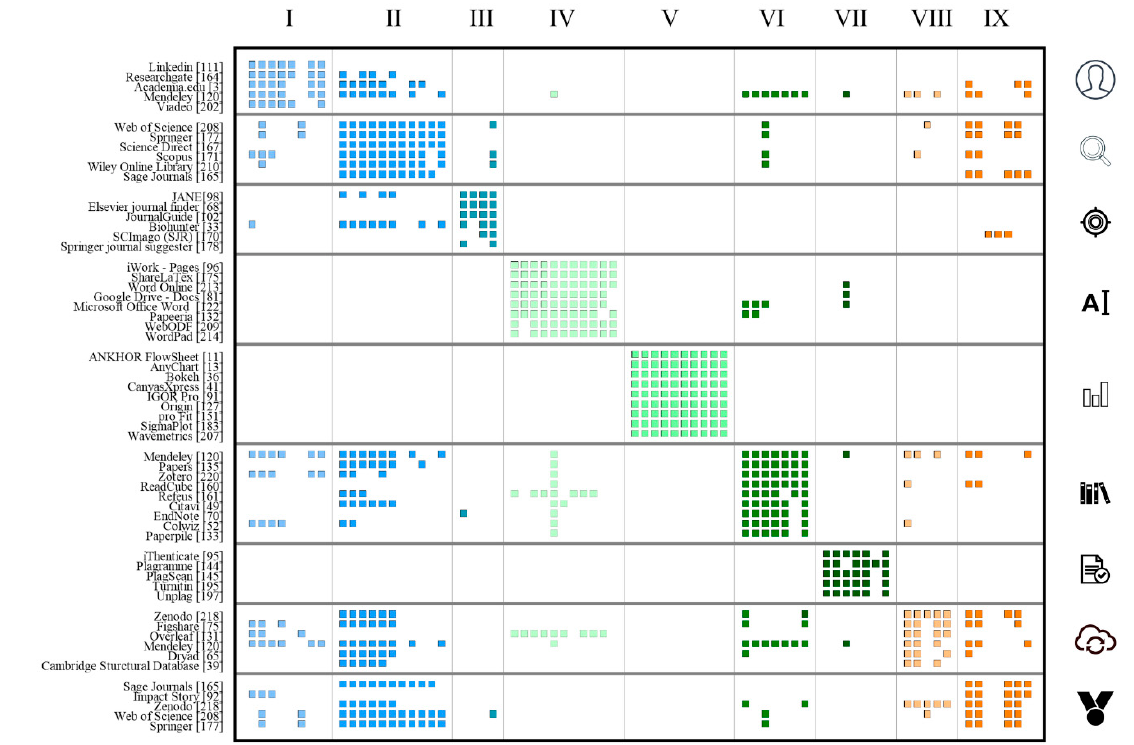
Figure 4. Top-ranked ITC tools by category trait map.